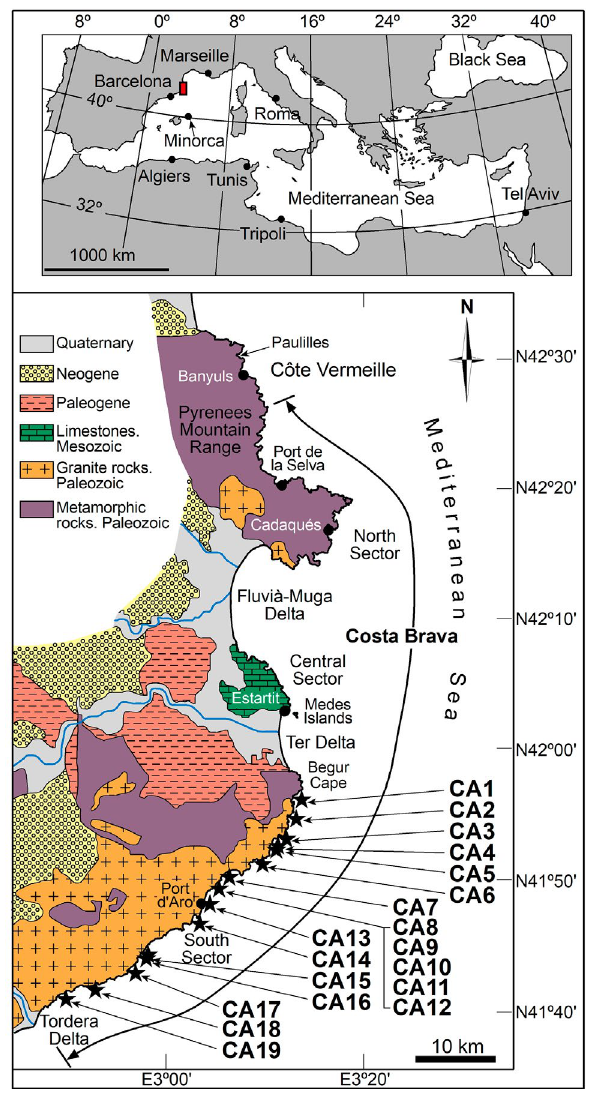
Fig. 1. – Location and geological setting of the study area. Beachrocks: CA1, Platja Fonda. CA2, Tamariu. CA3, Llafranc. CA4, Canadell. CA5, Port Pelegrí. CA6, Cap Planes. CA7, St Antoni. CA8, Paller. CA9, Puget. CA10, Roig. CA11, Belladona. CA12, Pi. CA13, Platja Aro. CA14, St Pol. CA15, Futadera. CA16, Giverola. CA17, Mar Menuda. CA18, Canyelles. CA19,